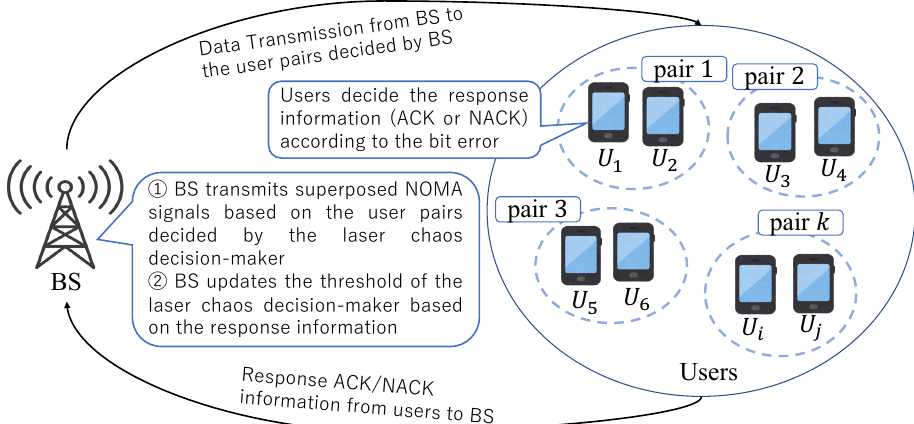
Figure 4. Outline of the proposed user pairing